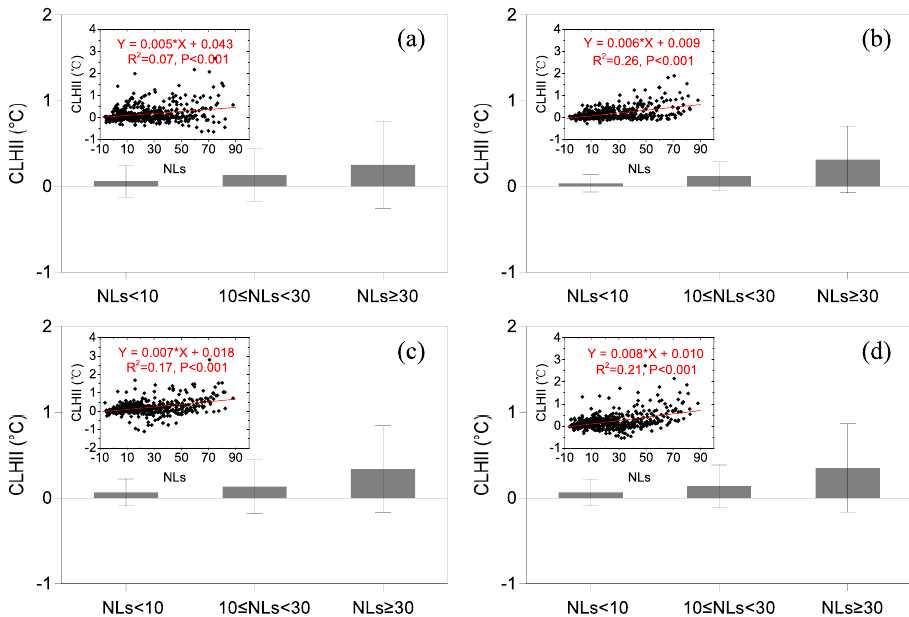
Figure 8. Relationships of CLHII with BI. The average of seasonal CLHII is shown for different BI bins (mean ± standard deviation). The insets show the correlation between CLHII and BI intensity. CLHII in ( a ) spring, ( b ) summer, ( c ) autumn, and ( d ) winter for different BI binned into 0.25 intervals. The red line is the linear regression line.